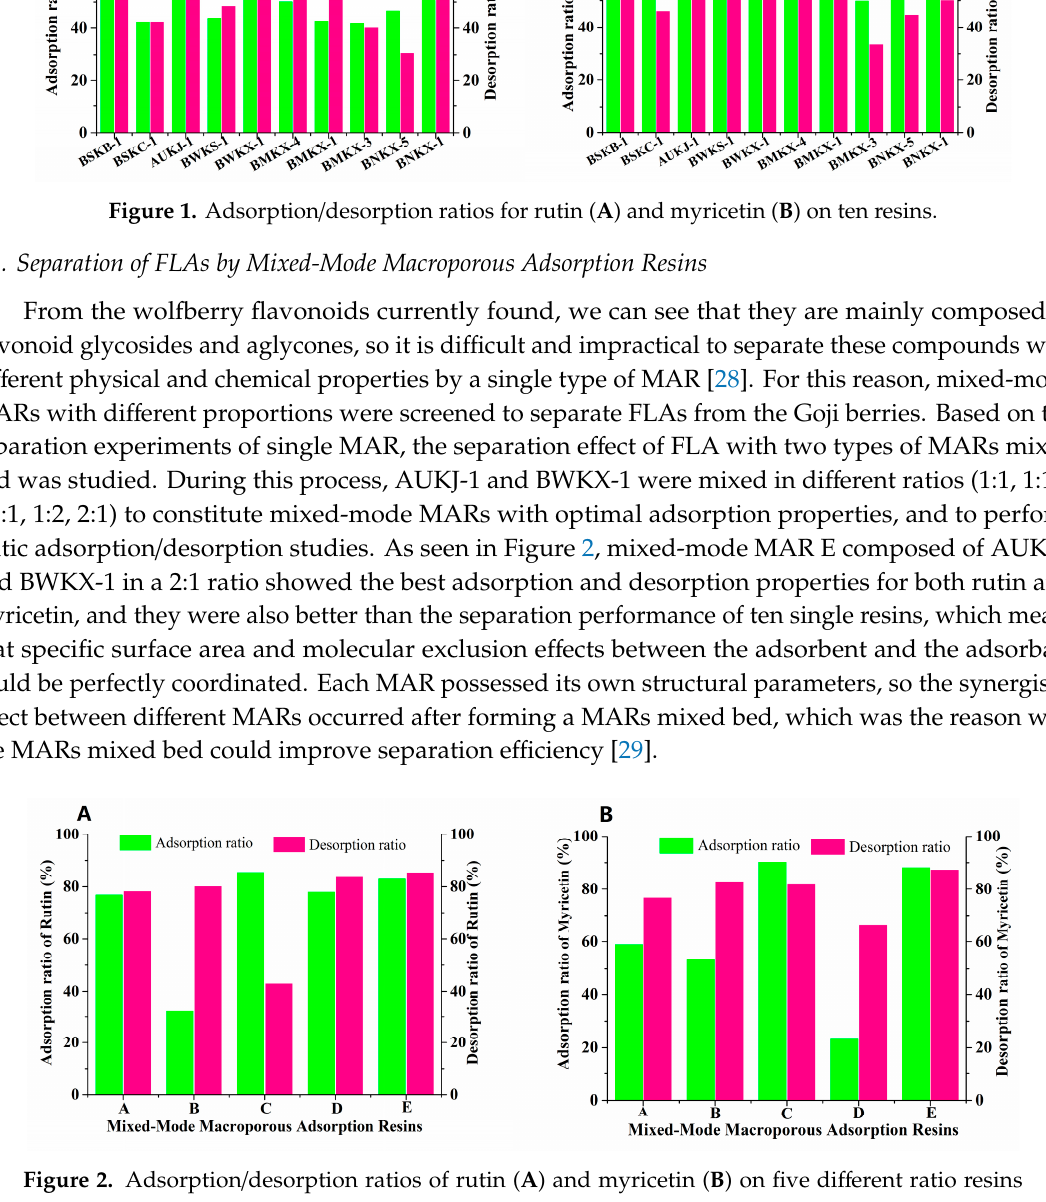
Figure 2. Adsorption/desorption ratios of rutin ( A ) and myricetin ( B ) on five different ratio resins